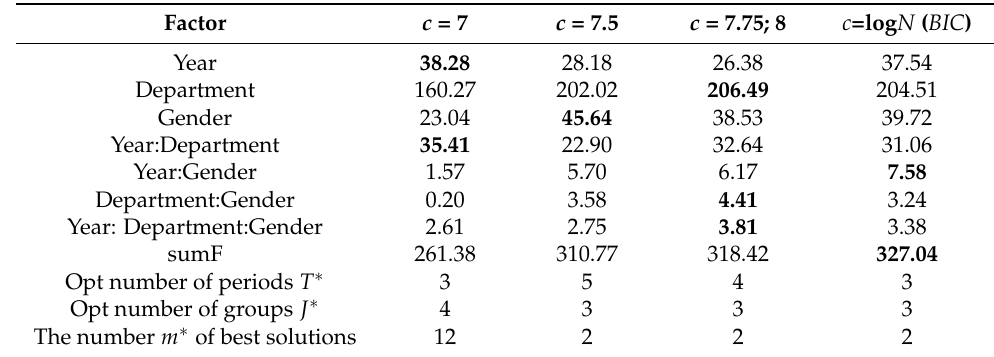
Table 2. F-statistics for the ANOVA model depending on the parameter c